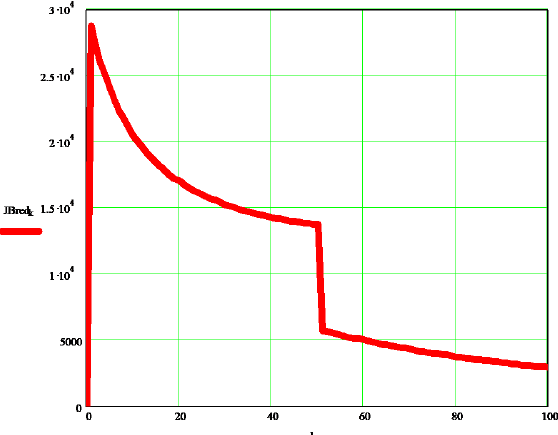
Figure 4. Variations of mass (mechanical) moments of inertia reduced to a coupling B (element 2).